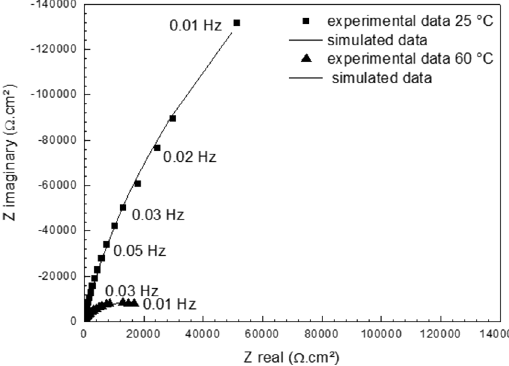
Figure 9. Nyquist diagram of TiN coated Ti–6Al–4V alloy in 2 M NaOH at 25 and 60 °C.